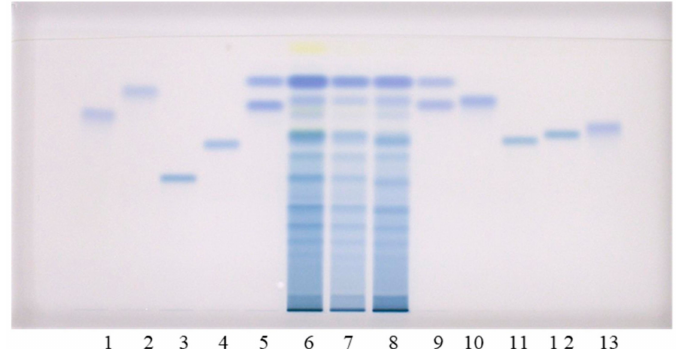
Figure 1. HPTLC chromatograms for the qualitative determination of flavan-3-ols and proantho- cyanidins in STSs from rhizomes (2 µ L, 50 mg/mL) of Japanese (track 6), Bohemian (track 7) and giant (track 8) knotweed based on standards. The HPTLC silica gel plate was developed with tol uene— acetone—formic acid (3:6:1, v/v ) and documented at white light after derivatization with DMACA detection reagent. Applications of standards: ( − )-gallocatechin gallate (0.2 µ g; track 1), ( − )-catechin gallate (0.2 µ g; track 2), procyanidin C1 (0.3 µ g; track 3), procyanidin B3 (0.2 µ g; track 4), ( − )- epicatechin (0.1 µ g; track 5, higher R F ), ( − )-epigallocatechin (0.2 µ g; track 5, lower R F ), (+)-catechin (0.1 µ g; track 9, higher R F ) ( − )-gallocatechin (0.2 µ g; track 9, lower R F ), ( − )-epicatechin gallate (0.2 µ g; track 10), procyanidin B1 (0.2 µ g; track 11), procyanidin B2 (0.2 µ g; track 12) ( − )-epigallocatechin gallate (0.2 µ g; track